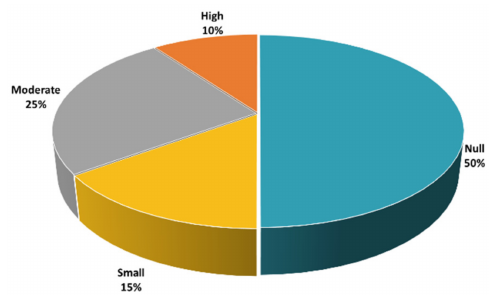
Figure 4. Sophistication level of companies in central region of